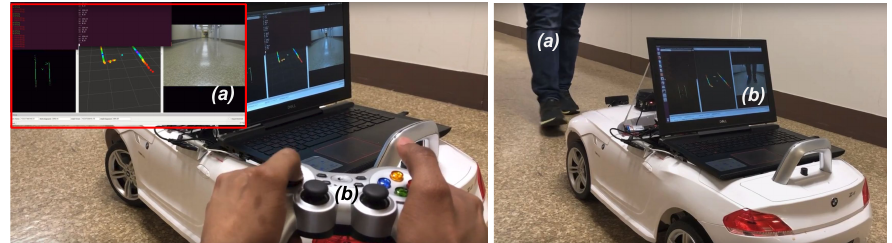
Figure 21. Rviz screen with multiple ROS nodes to use sensor packages. ( Left ): Remote control. ( a ) A screenshot of the ROS Visualization and our remote control ROS node. ( b ) A remote controller in action. Video: https://youtu.be/Vuj5jBDjNVs (accessed on 18 November 2021) . ( Right ): ( a ) An object. ( b ) ROS topic viewers from the LIDAR and the front camera. Video: https://youtu.be/ vomTh7FF7K8. (accessed on 18 November